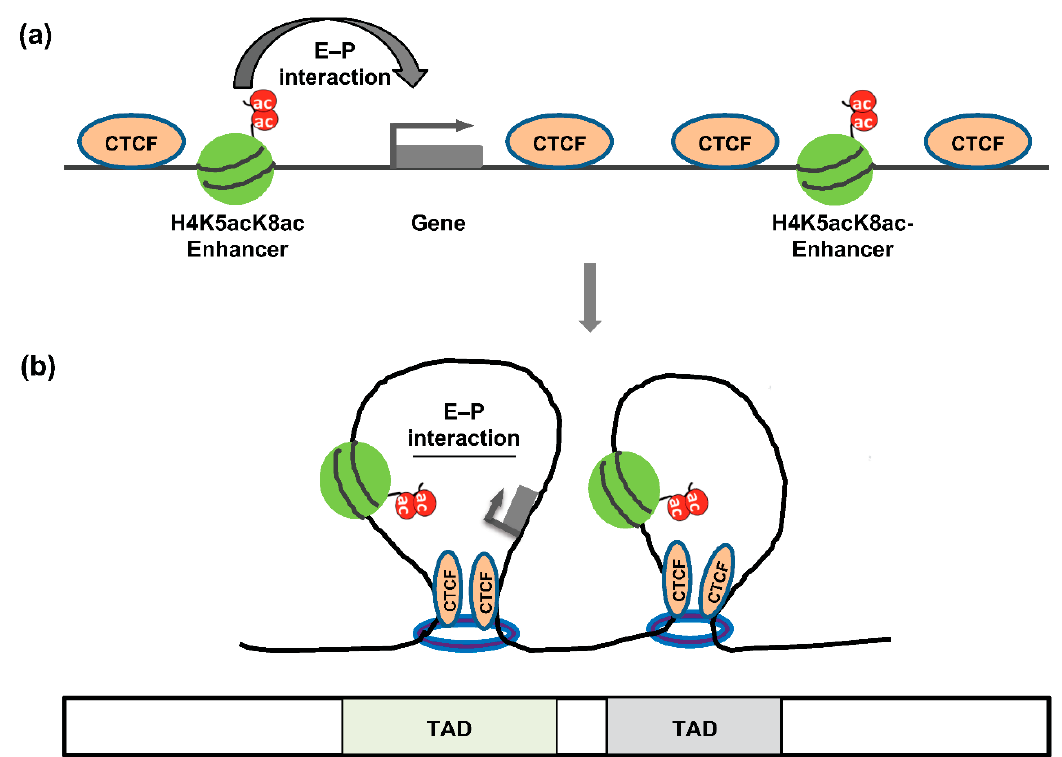
Figure 3. Schematic of E–P interaction and TAD into genome organization. ( a ) A hypothetical E–P interaction. An enhancer enriched with histone modification, ( i.e., H4K5acK8ac) drives the expression of the associated gene by forming the E–P interaction. CTCF enrichments are shown that mediate the formation of TAD ( b ) TADs form the genome organization. An E–P interaction occurs within the TAD, and regions within the TAD are more likely to interact each other than regions outside the TAD. Cohesin is indicated by blue rings.